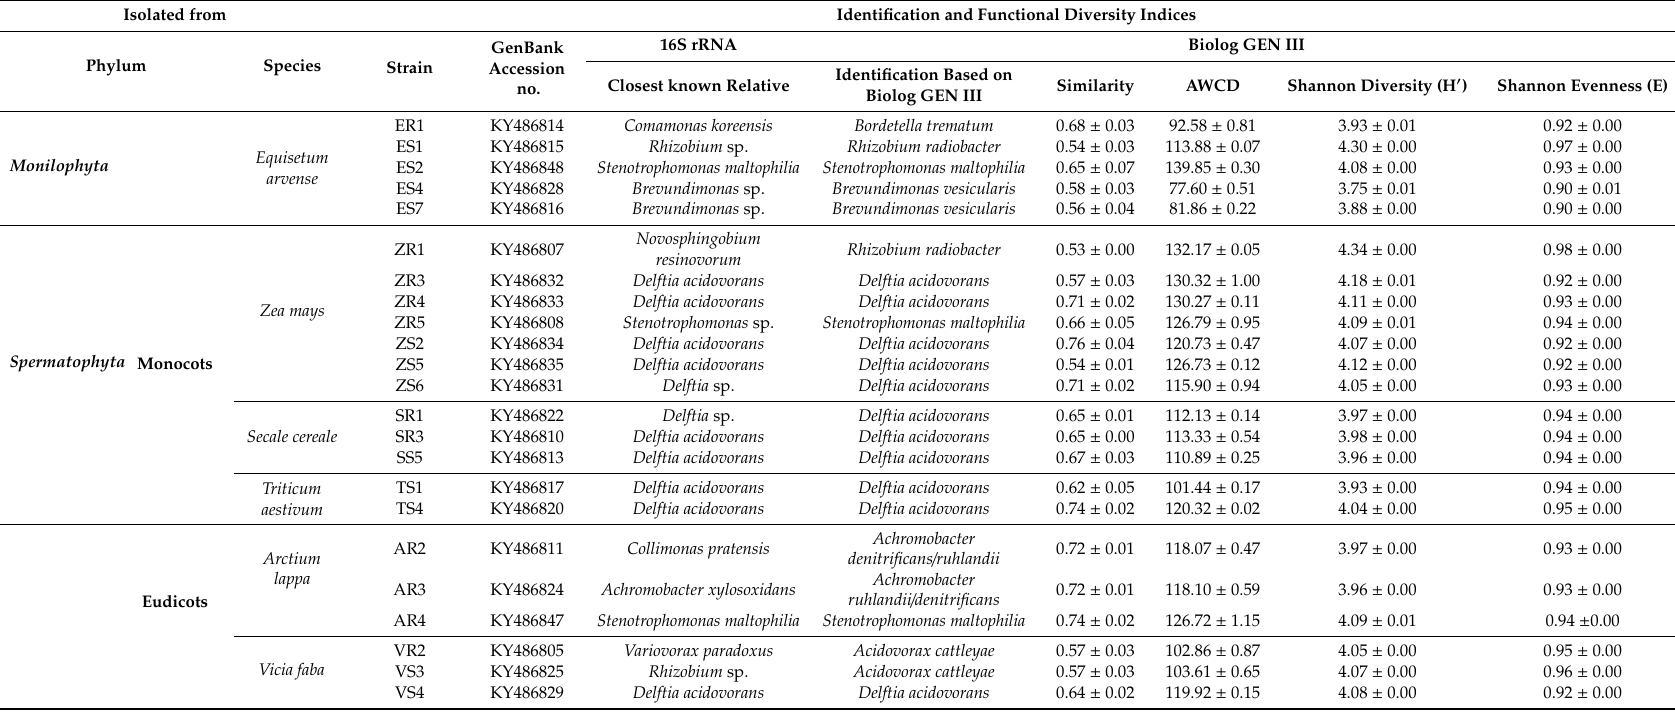
Table 1. Representative data of identification based on Biolog GEN III plates for 23 tested strains. A comparison with an identification based on the sequencing of the 16S rRNA gene was presented. The table presents the results of average well color development (AWCD), Shannon evenness (E) and Shannon diversity index (H (cid:48) ) values based on substrates used in Biolog GEN III. The values are means ± standard deviation (SD; n =